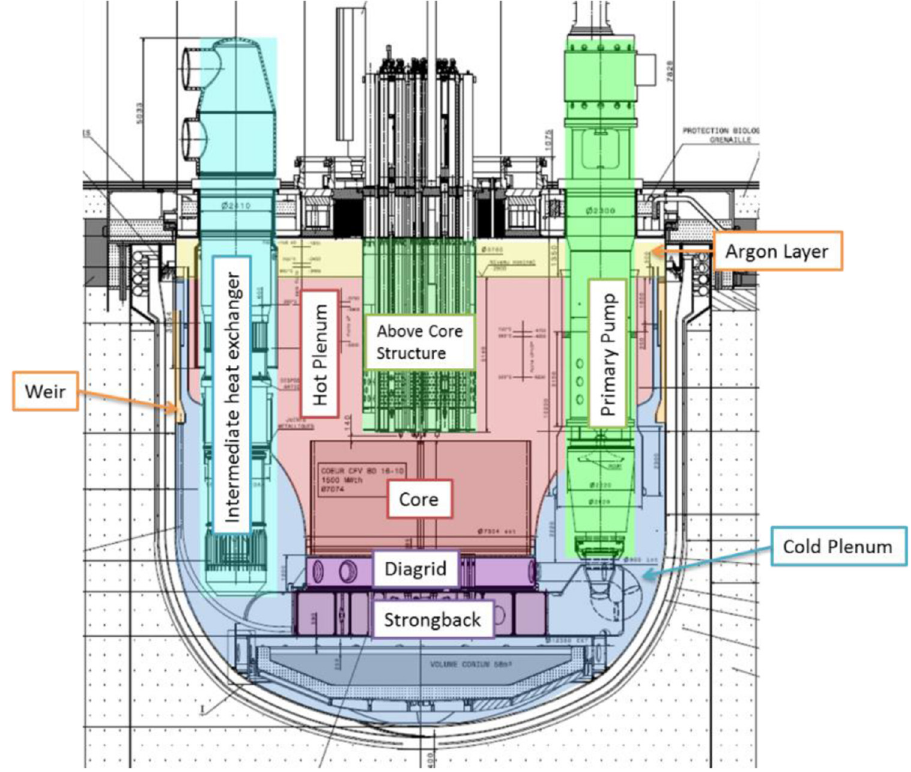
Fig. 2. Schematic of the studied SFR primary circuit.